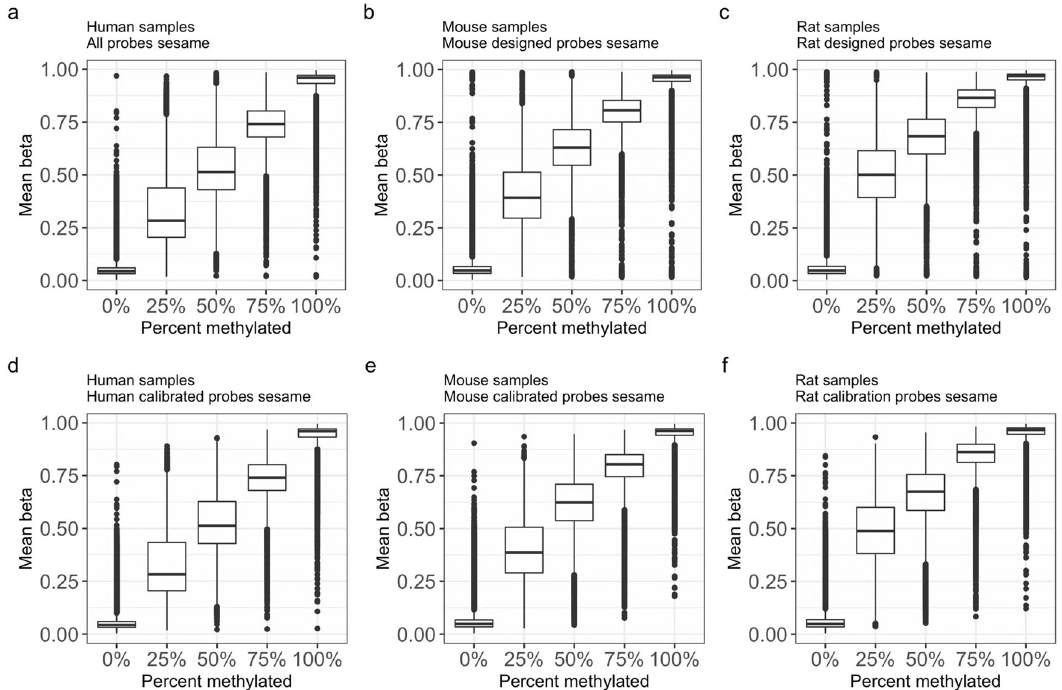
Fig. 4 Distribution of beta values after SeSaMe normalization. a – c Distribution of beta values (relative intensity) of all probes on the array after SeSaMe normalization for a human samples, b mouse samples, and c rat samples. These cytosines are based on the CMAPS design criteria, i.e., a n = 35,453 human cytosines, b n = 21,900 mouse cytosines, c n = 18,157 rat cytosines. d – f Analogous to a – c but based on mappable cytosines from QuasR and after using calibration data to identify and remove severely outlying cytosines. Speci fi cally, the lower panels use respective subsets of cytosines whose Pearson correlation with Percent methylated exceeds 0.8, which was: n = 37,152 CpGs for human, n = 27,966 for mouse, and n = 25,669 for rat. Beta-valued distributions are heteroscedastic in that distributions at a fractional methylation value close to 0.5 are expected to have a higher variance than those at fractional value close to zero or 1. Based on the binomial distribution, one would expect that the variance and mean value across of the SeSaMe normalized beta values across designed CpGs follow the following relationship: variance = constant*mean*(1 − mean). Indeed, in a separate analysis, we fi nd that the left-hand side (variance) is highly correlated with the mean*(1 − mean) in mice (Pearson correlation r = 0.92), rats ( r = 0.95), and humans ( r = 0.86). It can be advisable to use statistical models and distributions that model the over-dispersion inherent in these data. Both array and sequencing methods that use bisul fi te conversion followed by ampli fi cation can lead to biases in the ratio of converted to unconverted strands (beta values) 67 , which could explain the broad peaks we see in the estimate of calibration data. Each boxplot visualizes the median value and the upper and lower quartile. The whiskers extend to the most extreme data point, that is, no more than 1.5 times the interquartile range from the